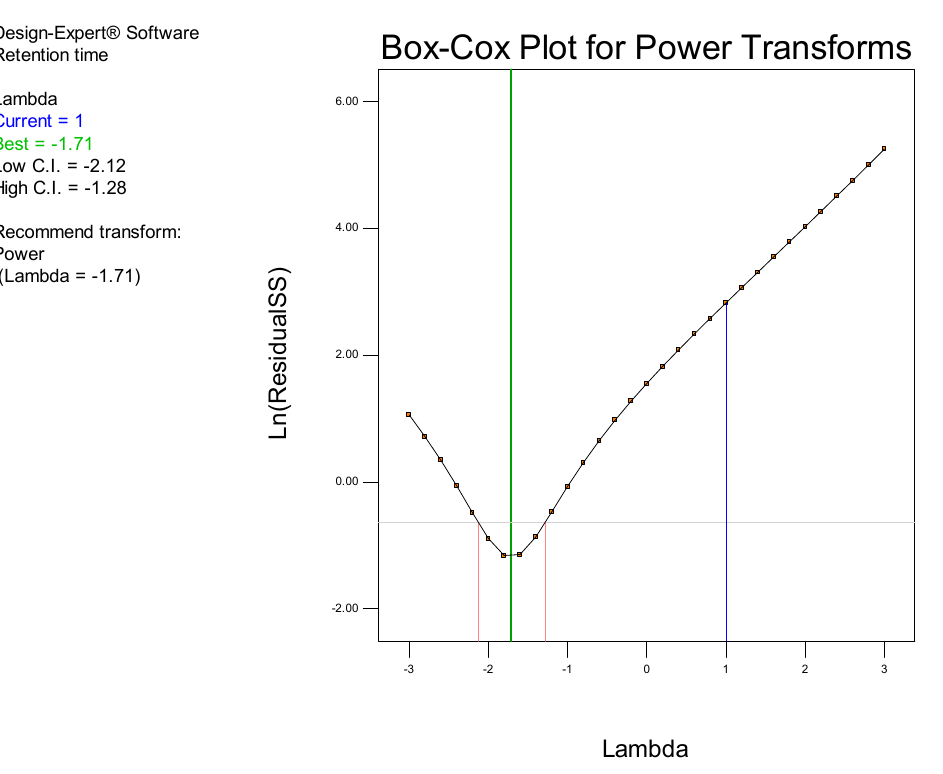
Figure 4. Box-Cox plot for power transformation for retention time prior to transformation.